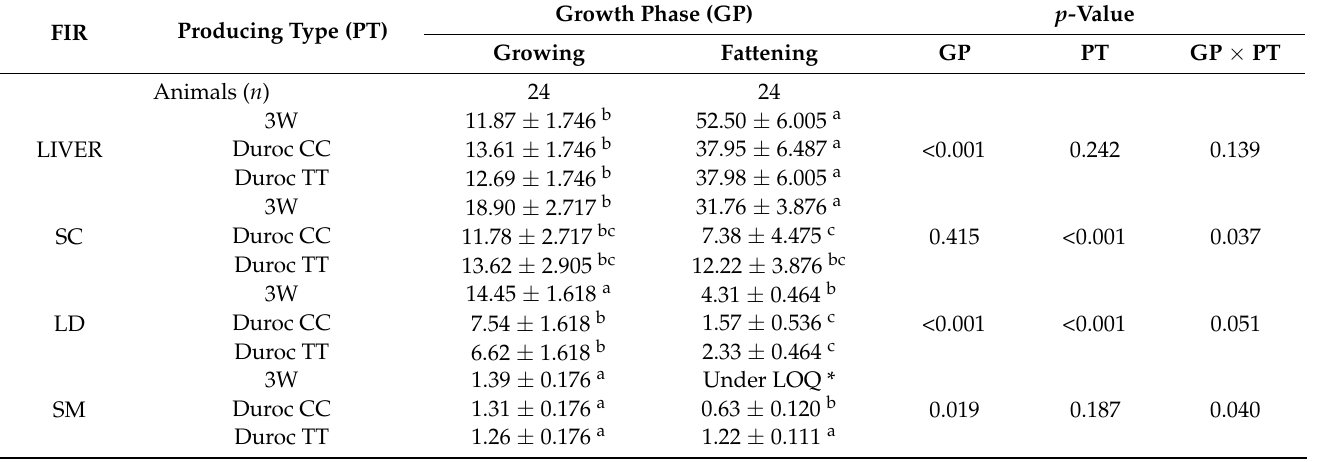
Table 5. Least square means ( ± SE) for fractional incorporation rate (FIR, %) of deuterated stearic acid (d 35 -C18:0) in the liver, subcutaneous adipose tissue (SC), longissimus dorsi (LD) and semimem- branosus (SM) muscles, between three-way (3W) crossbred pigs and purebred Duroc TT/CC for the SCD genotype, belonging to two growth phases (growing vs.